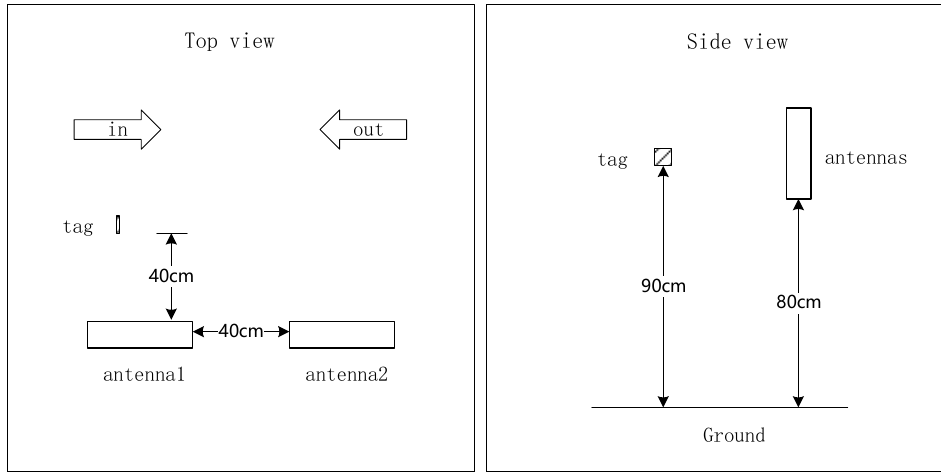
Figure 4. System deployment for the RSSI-based model.